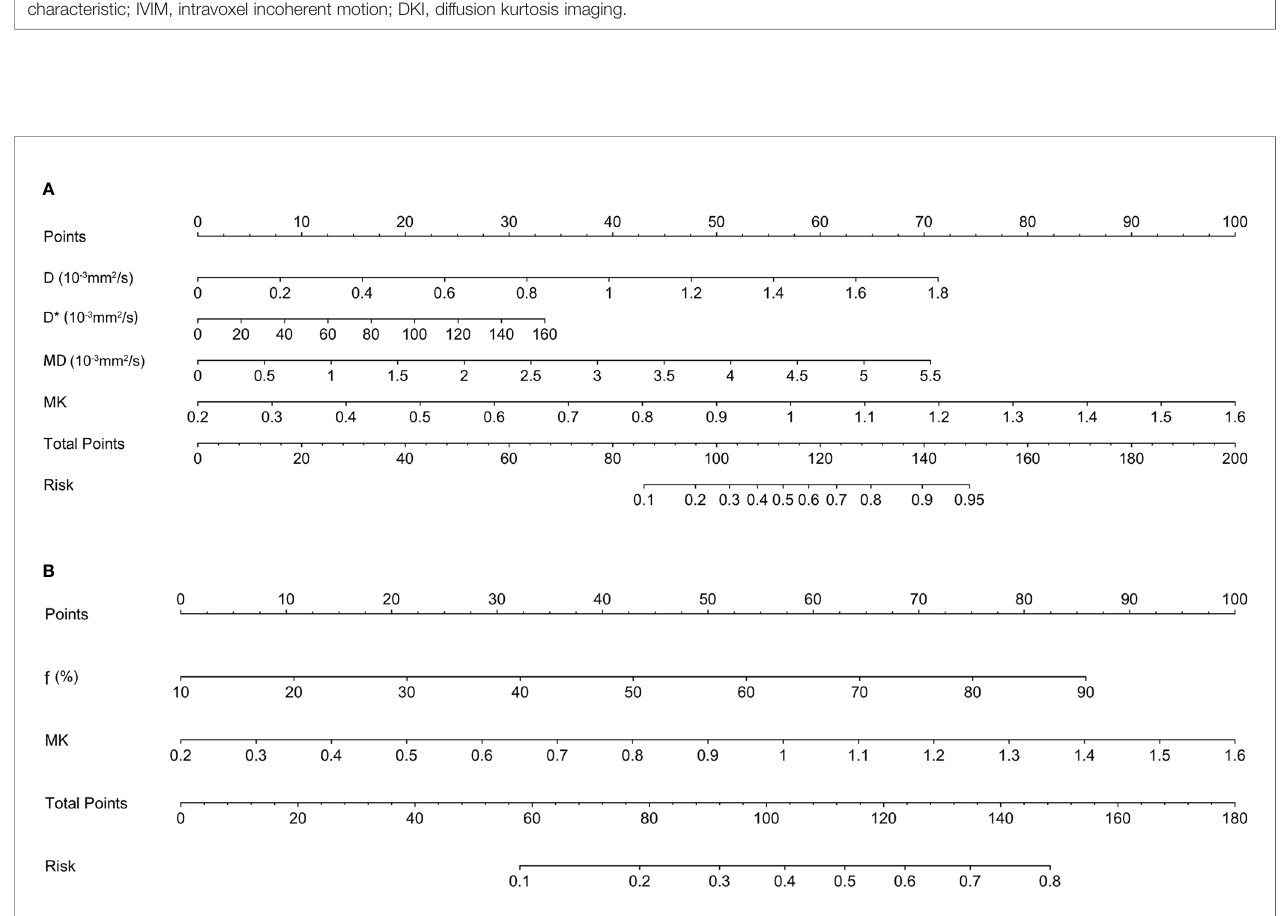
FIGURE 6 | The nomogram for predicting the Luminal subtypes (A) and triple-negative subtype of breast cancer (B)